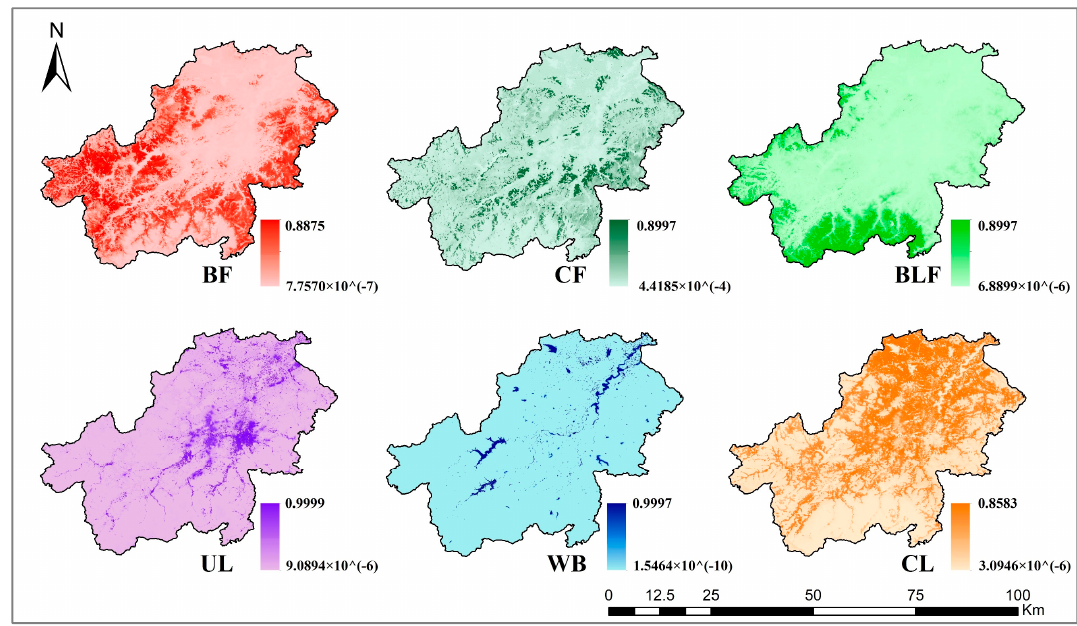
Figure 8. The land suitability probabilities of the six land-use types in 2008.